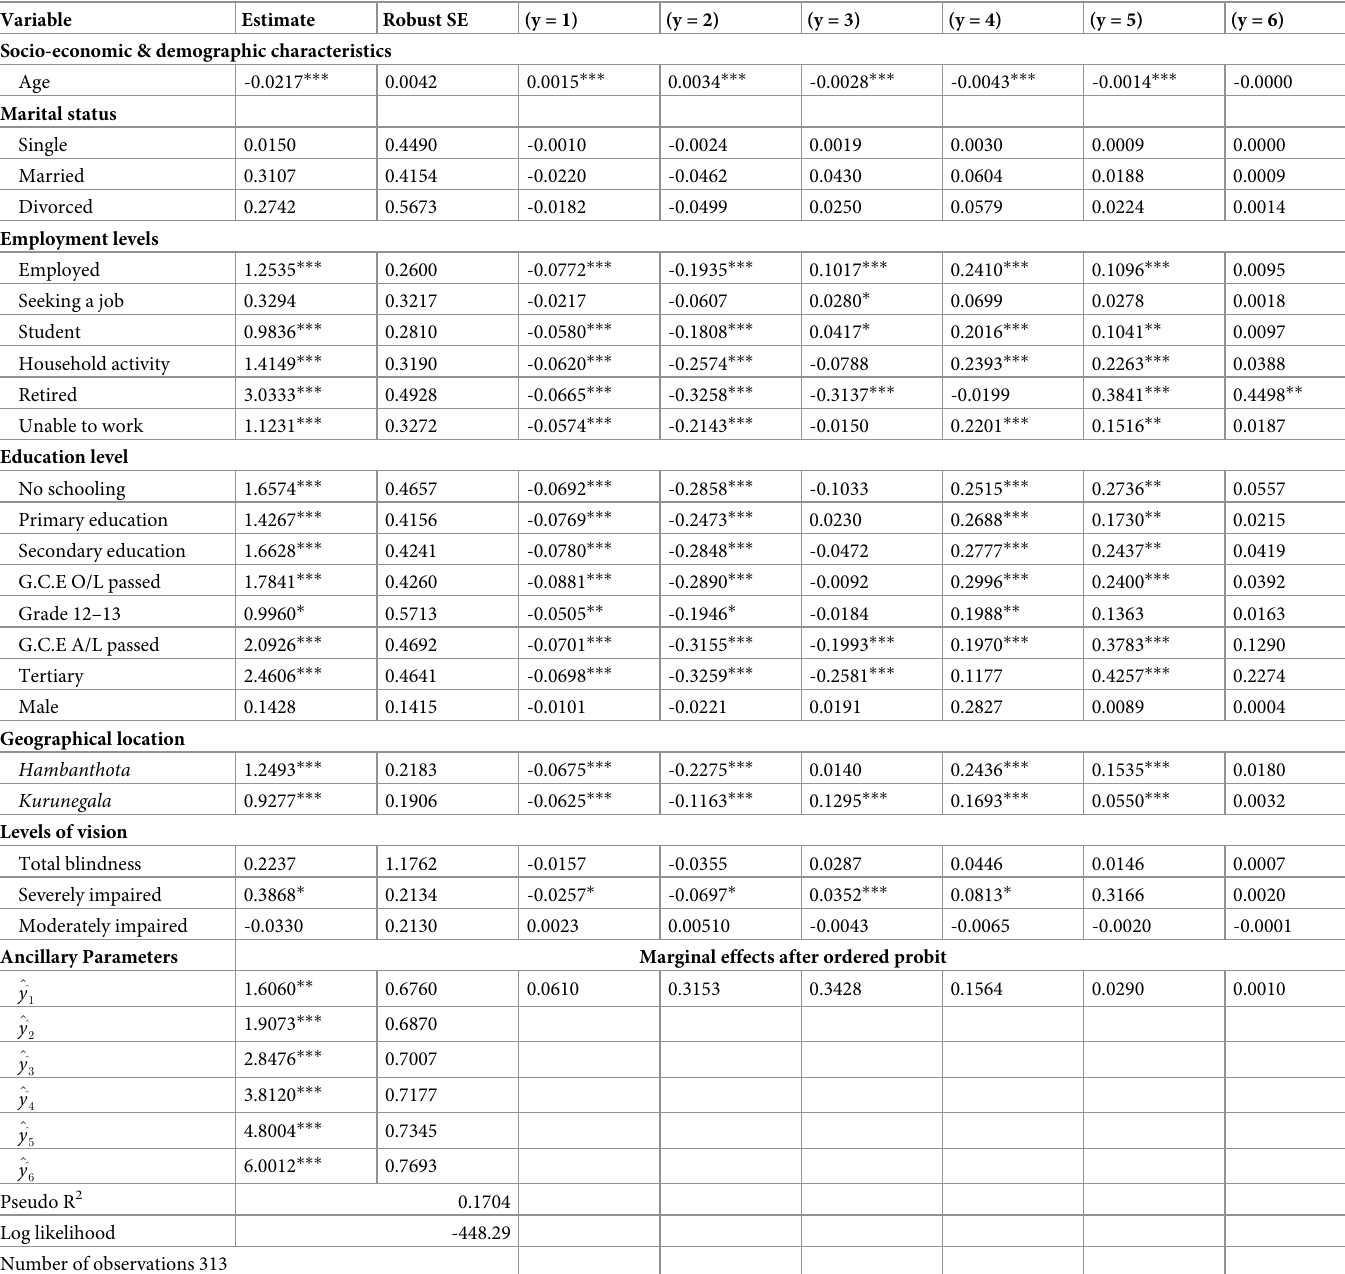
Table 5. Initial ordered probit regression results for all variables (Step